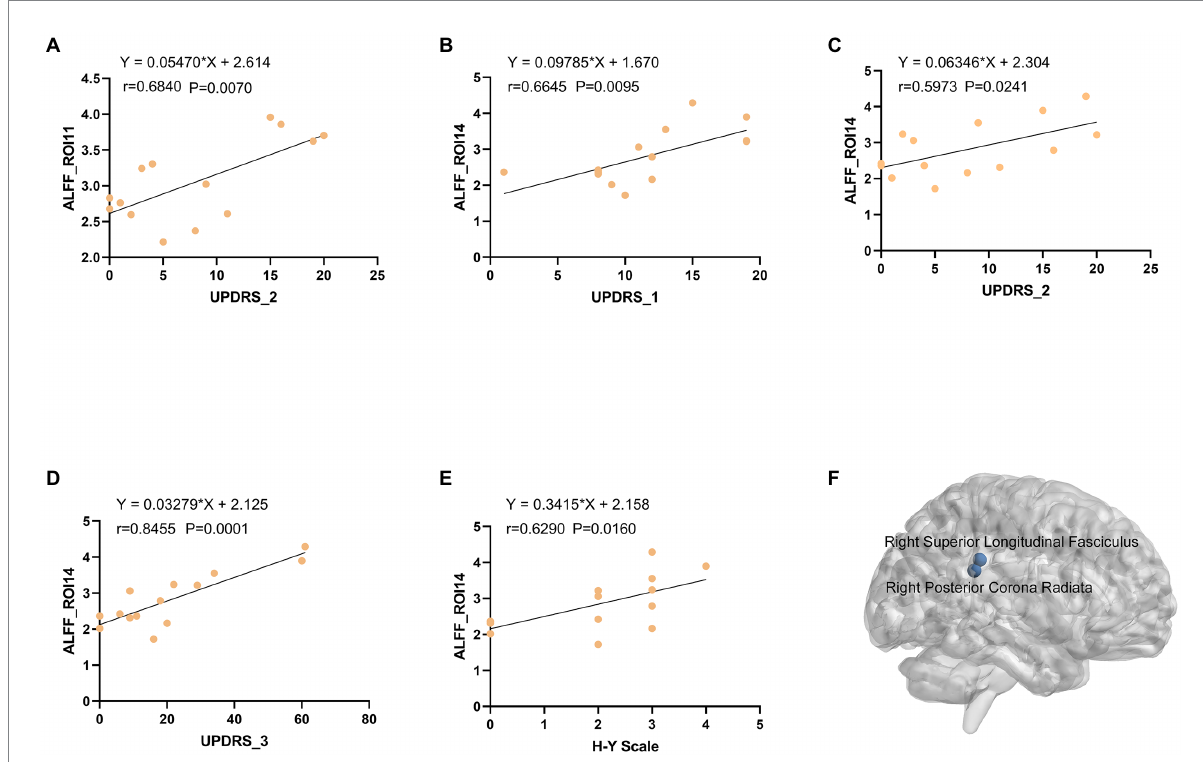
FIGURE 7 (A) The ALFF values of right ROI11 were positively correlated with UPDRS-2 ( r = 0.5946, p = 0.0249). (B) The ALFF values of left ROI14 were positively correlated with UPDRS-1 ( r = 0.5768, p = 0.0308). (C) The ALFF values of left ROI14 were positively correlated with UPDRS-2 ( r = 0.5768, p = 0.0308). (D) The ALFF values of left ROI14 were positively correlated with UPDRS-3 ( r = 0.5768, p = 0.0308). (E) The ALFF values of left ROI14 were positively correlated with H-Y Scale ( r = 0.5768, p = 0.0308). (F) Three-dimensional map of the Right Posterior Corona Radiata (ROI11) and Right Superior Longitudinal Fasciculus (ROI14) brain regions. ALFF: amplitude of low-frequency fluctuations, ROI: region of interest, UPDRS: Unified Parkinson Disease Scale, H-Y Scale: Hoehn and Yahr